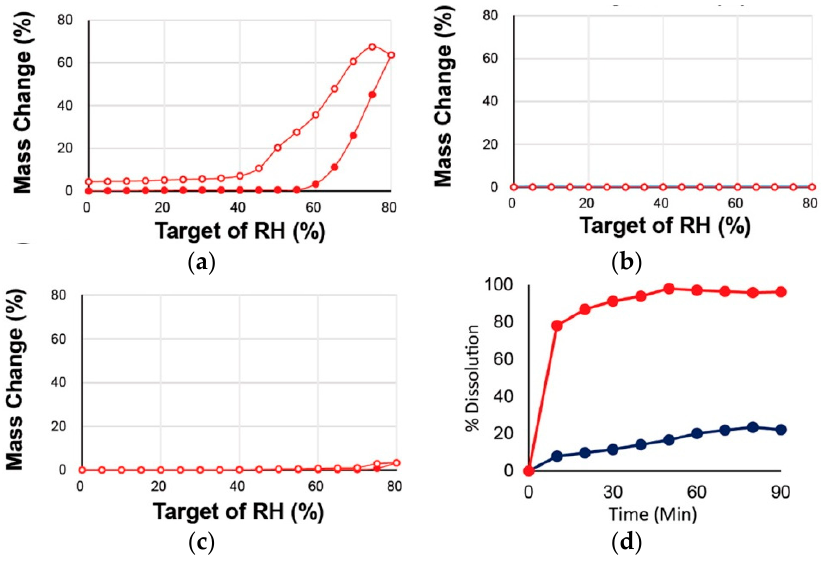
Figure 30. DVS of ( a ) MET,( b ) GLI, and ( c ) GLI-MET salt showing hydration stability ( left ) and ( d ) higher dissolution rate of GLI-MET salt compared to pure drug GLI ( right ). Adapted with